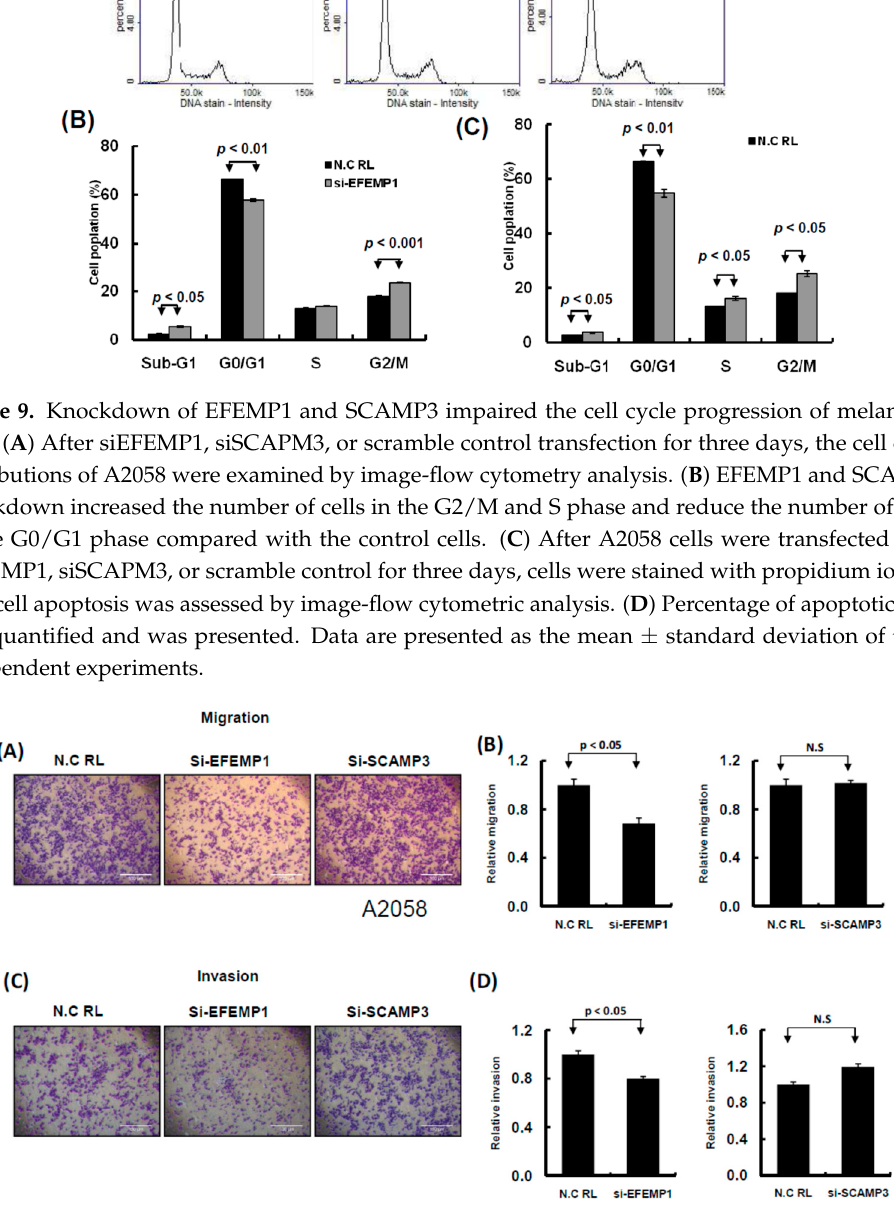
Figure 10. Knockdown of EFEMP1 and SCAMP3 expression influenced the cell invasion ability of melanoma cells. ( A ) and ( C ): Migration and invasion ability were examined by Transwell assay in A2058 cells. After knockdown of EFEMP1 and SCAMP3, or scramble control transfection for 24 h, cells were subjected to Transwell assay. The migrating and invading cells were stained with crystal violet solution. ( B ) and ( D ): Then, the numbers of migrating or invading cells were quantified by counting three different fields under a phase-contrast microscope. The cell photographs from a representative experiment are presented and the graph data were quantified using Ascent software. Data are reported as colonies compared with control (means ± SD).